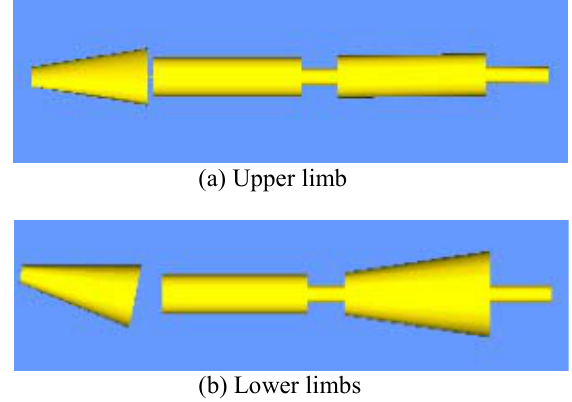
Simulation model (schematic view)